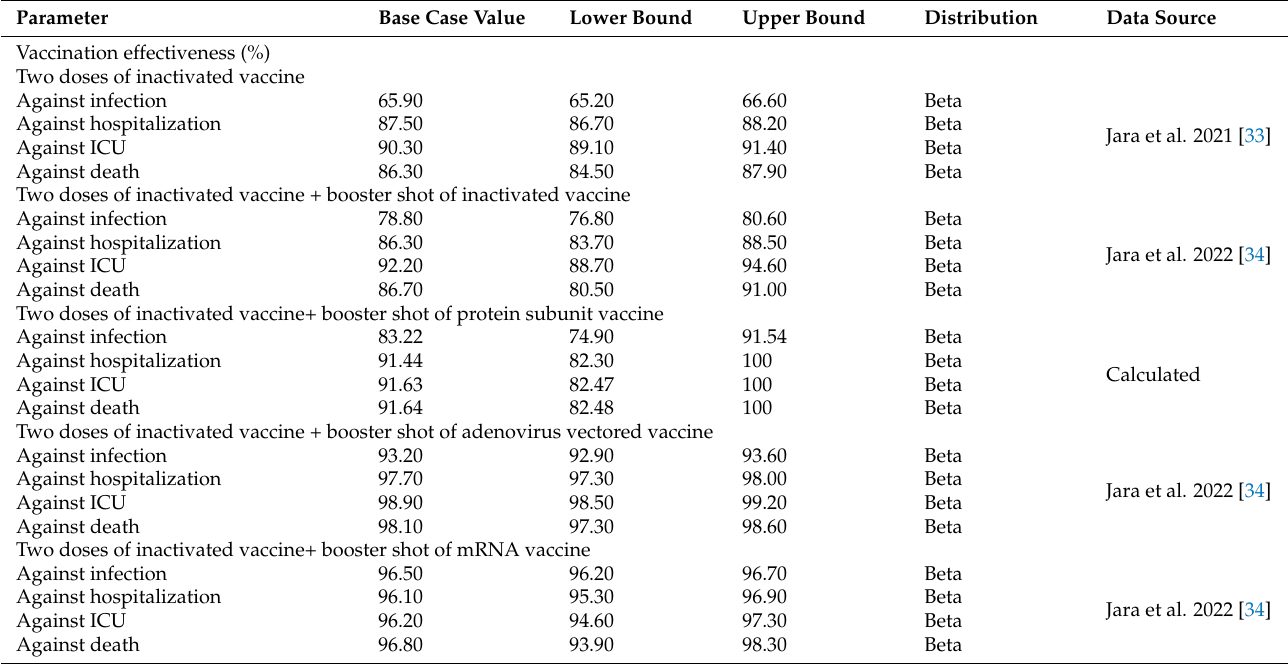
Table 1. Model Table 1. Model parameters.